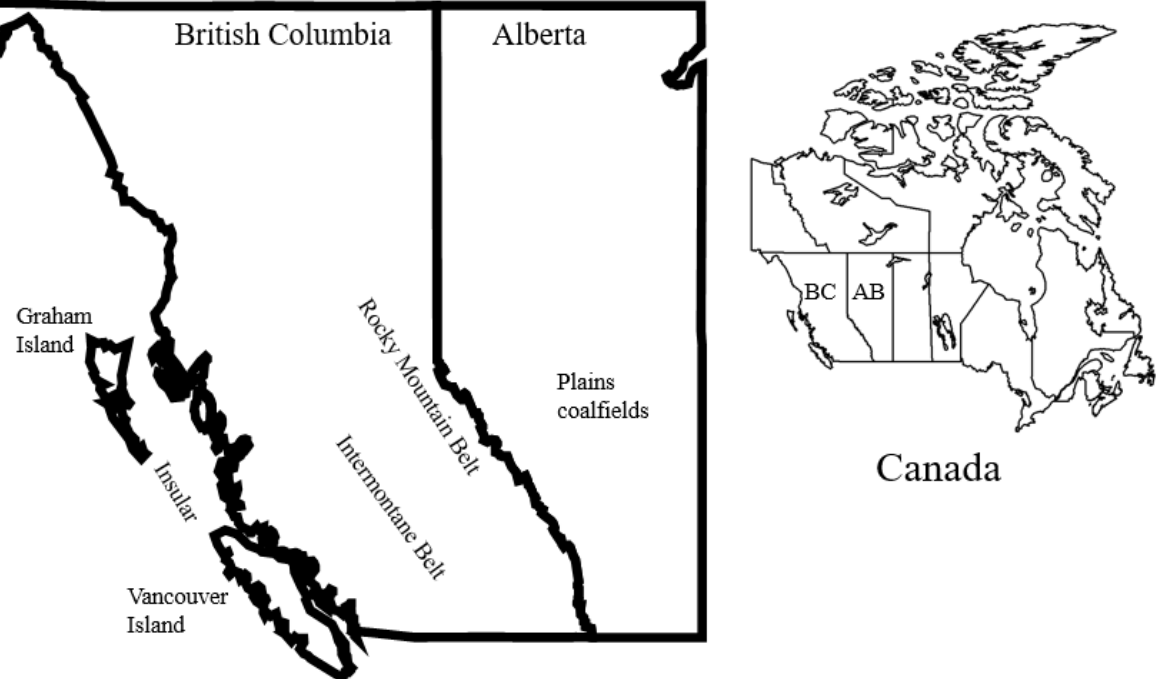
Figure 14. General locations of Cretaceous coalfields in British Colombia and